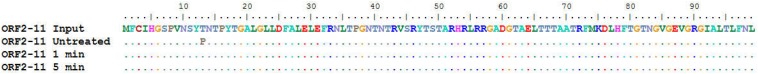
Amino acid sequence alignment of the N domain of the capsid protein (ORF2). The sequences for input, the untreated, treatment at 600 MPa for 1 min hold time and 600 MPa for 5 min hold time were aligned using Mega6 software and translated into amino acid sequences using BioEdit software.